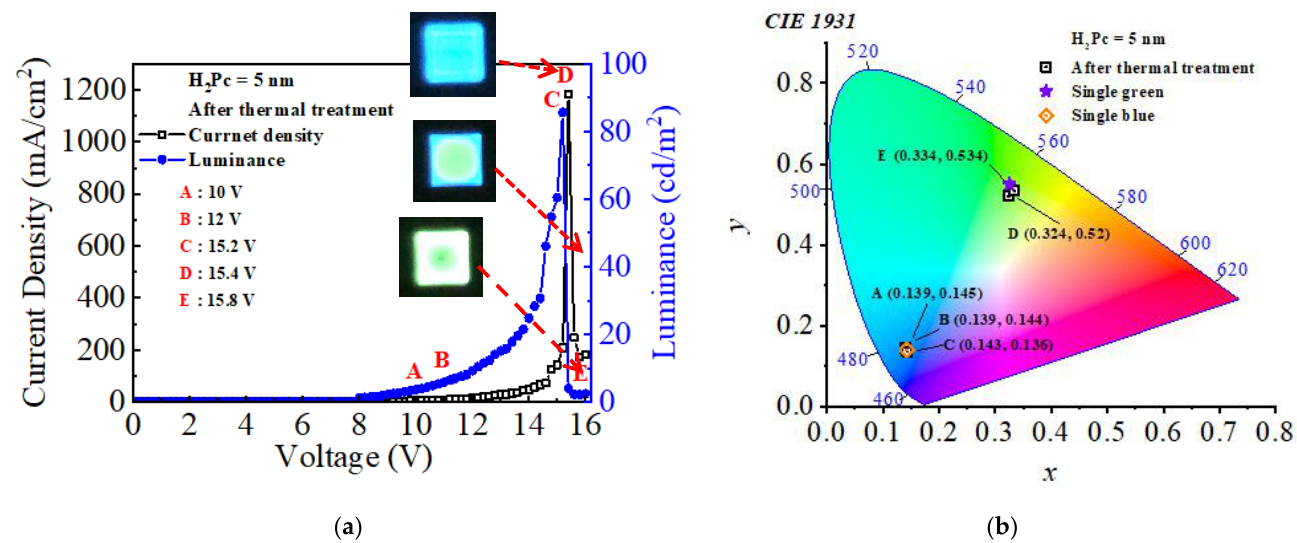
Figure 6. ( a ) J - V - L characteristics and ( b ) CIE color coordinates of the CTOLED after thermal treat-